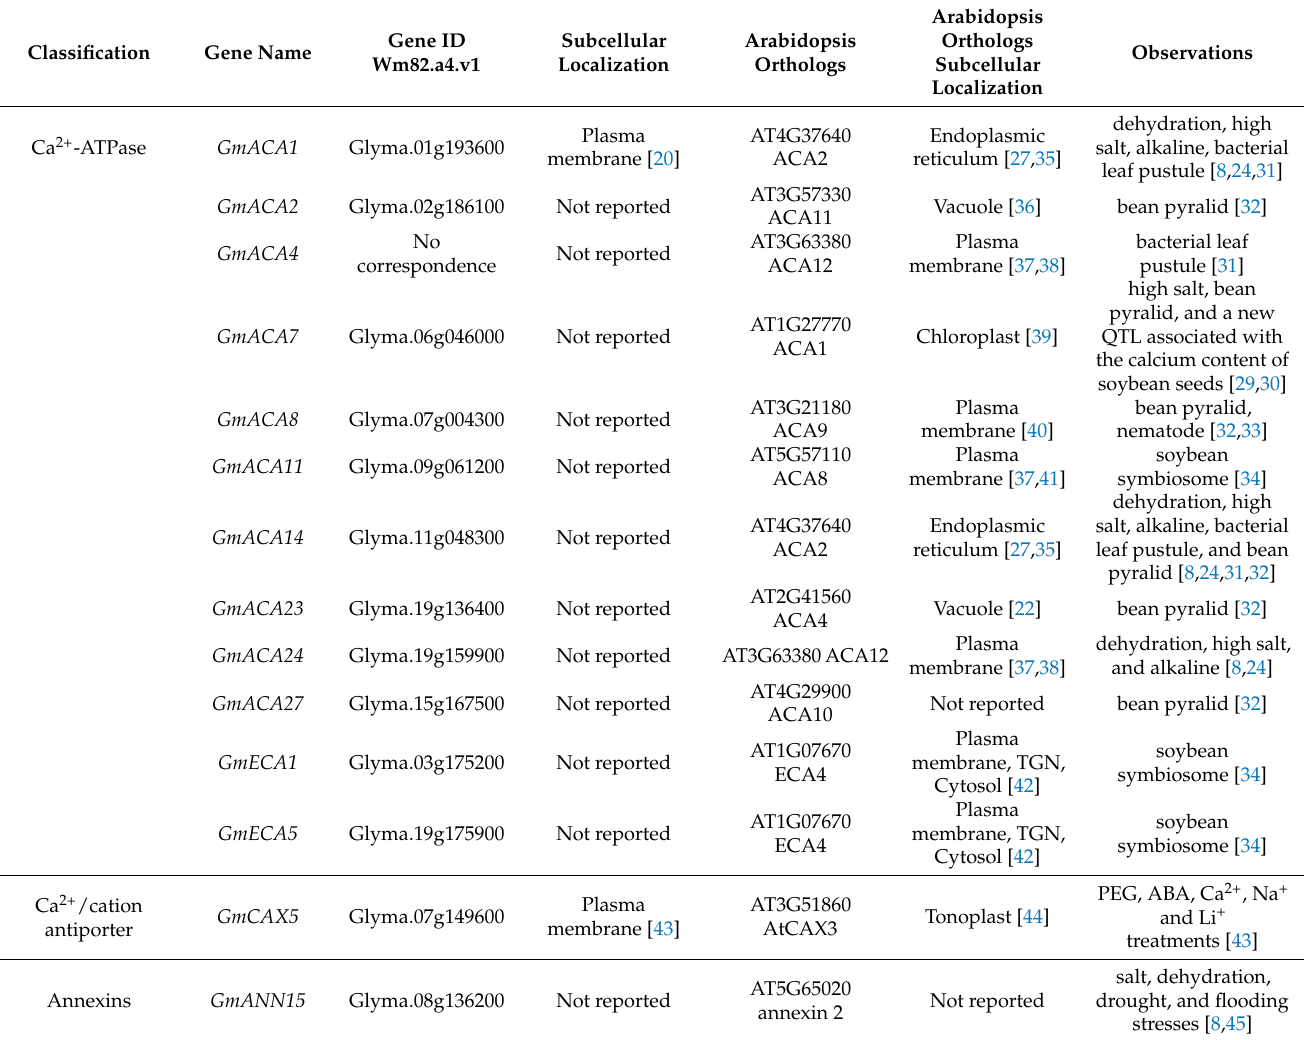
Table 1. List of soybean calcium transporters involved in reported stress response and physiological